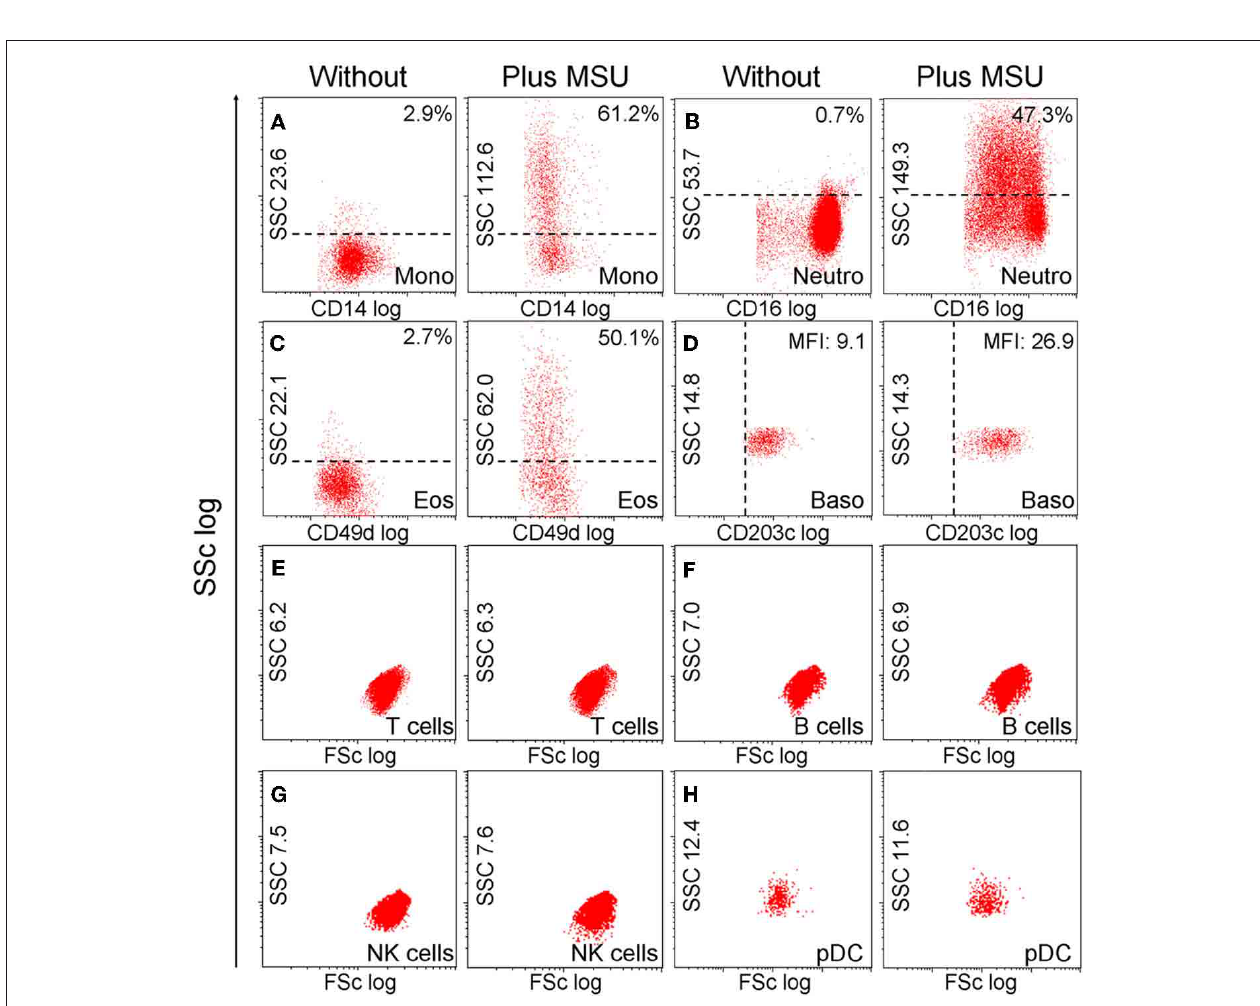
co-localization of DNAand histon H3. Erythrocytes and free MSUcrystals were dissolved by acid treatment. The MSU crystals were artificial colored in white. All experiments were performed at least 3 times. Scale bars, 100 μ m.